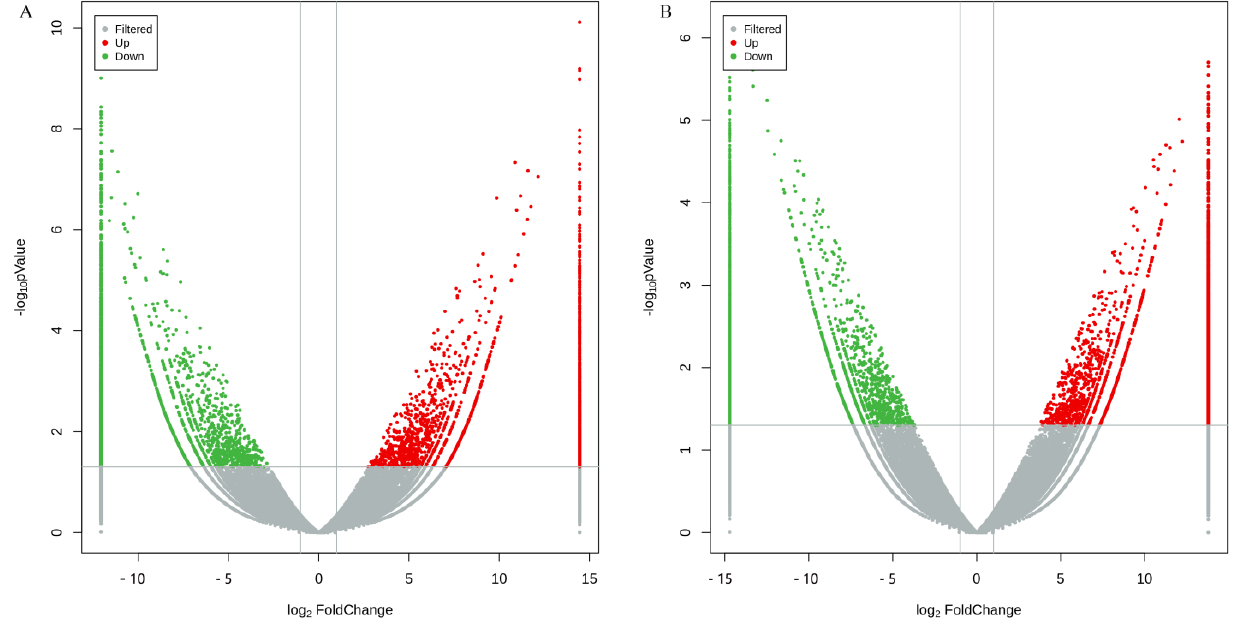
Figure 5. Volcanic diagrams of DEGs calculated based on raw counts from the brain ( A ) and thoracic ganglion ( B ) of M. rosenbergii . Statistically significant differentially expressed genes are shown in the red dots (up-regulation in male prawn) and green dots (down-regulation in female prawn), and volcanic plots were obtained by using log 2 (fold-change) values and p -values.